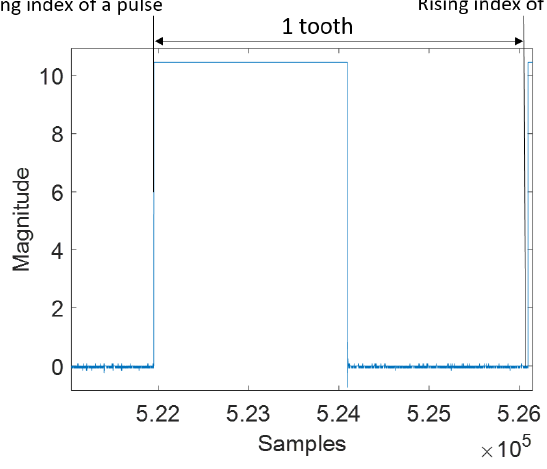
Figure 6. A single pulse of a pickup sensor